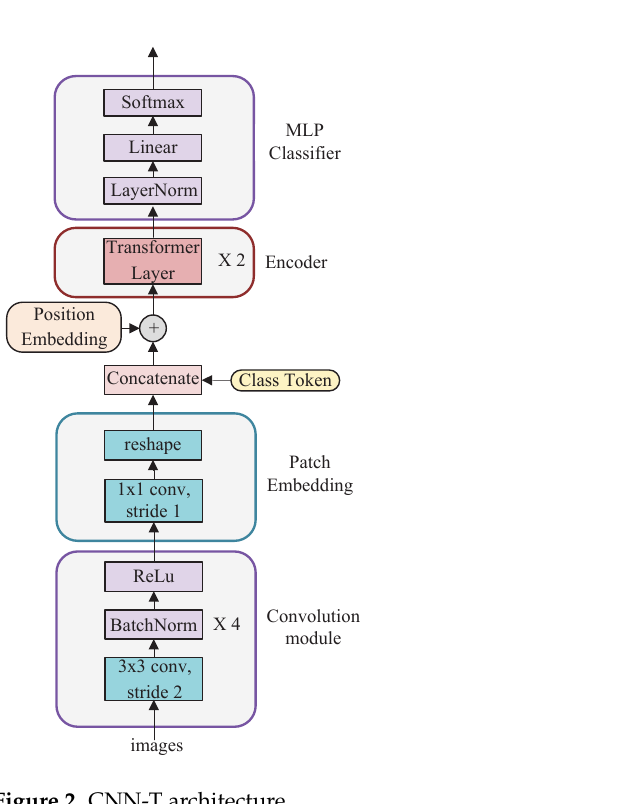
Figure 2. CNN-T architecture.